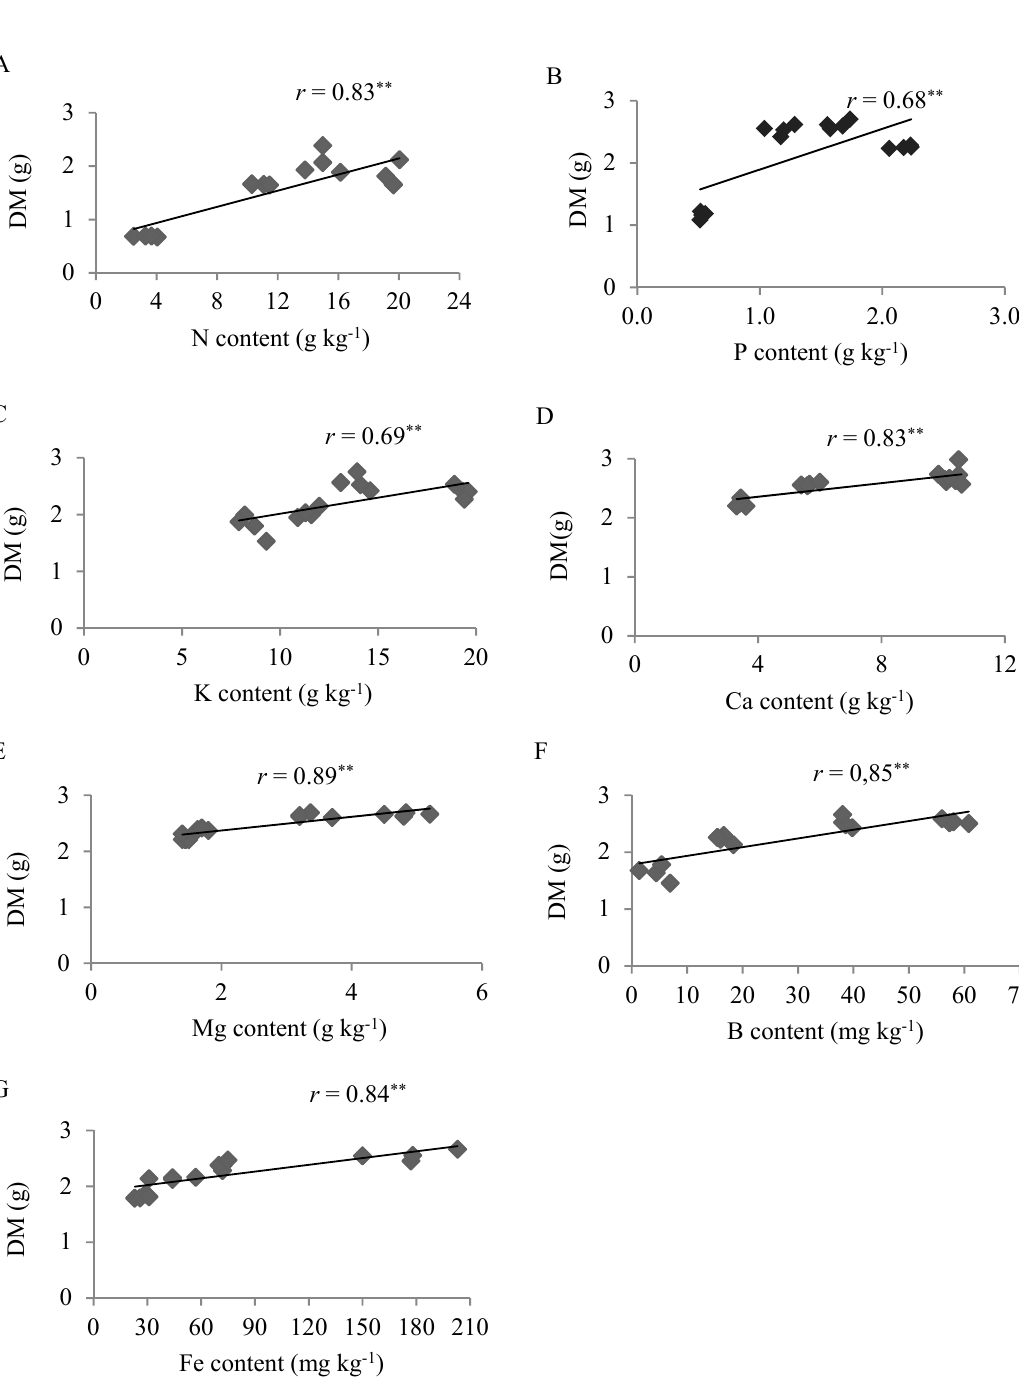
Figure 2. Correlation between leaf nitrogen ( A ), phosphorous ( B ), potassium ( C ), calcium ( D ), magnesium ( E ), boron ( F ) and iron ( G ) content and dry matter (DM) of experimental plot samples in Eucalyptus spp. rooted cuttings, ** Significant at 1% probability using the t-test. Assessment of DQI dispersion as a function of N content indicated a positive linear correlation in experimental plot samples (Figure 3), but no significant correlations for the other nutrients.